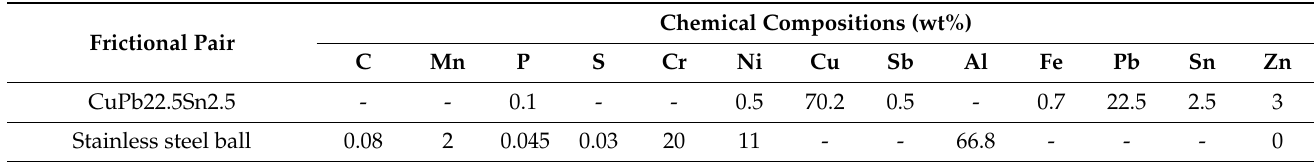
Table 2. Chemical composition and related parameters of the frictional